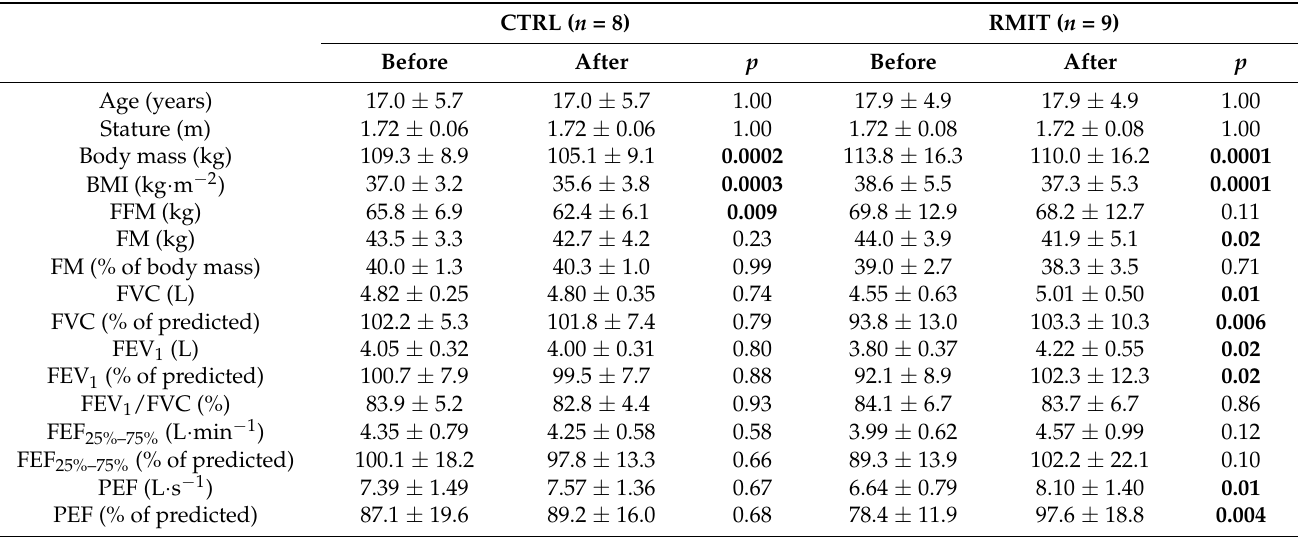
Table 2. Anthropometric characteristics and pulmonary function of the patients before and after the standard intervention of body mass reduction combined with control training and with